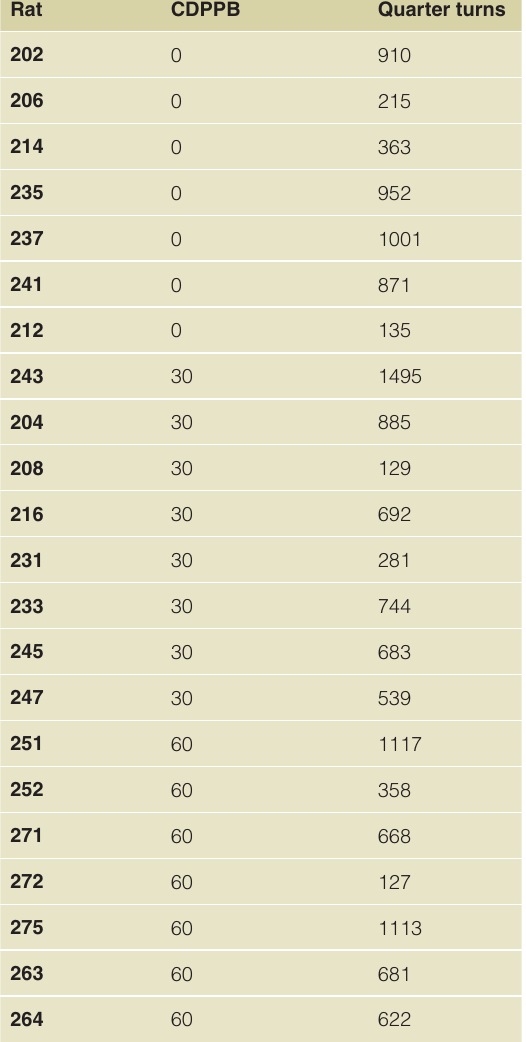
Table S5. CDPPB (0, 30, 60 mg/kg) effects on METH locomotor response (total quarter turns over 90 min) – rats with histories of saline injections. In the Day 16 tests using 0.5 mg/kg METH in all groups, rats with a history